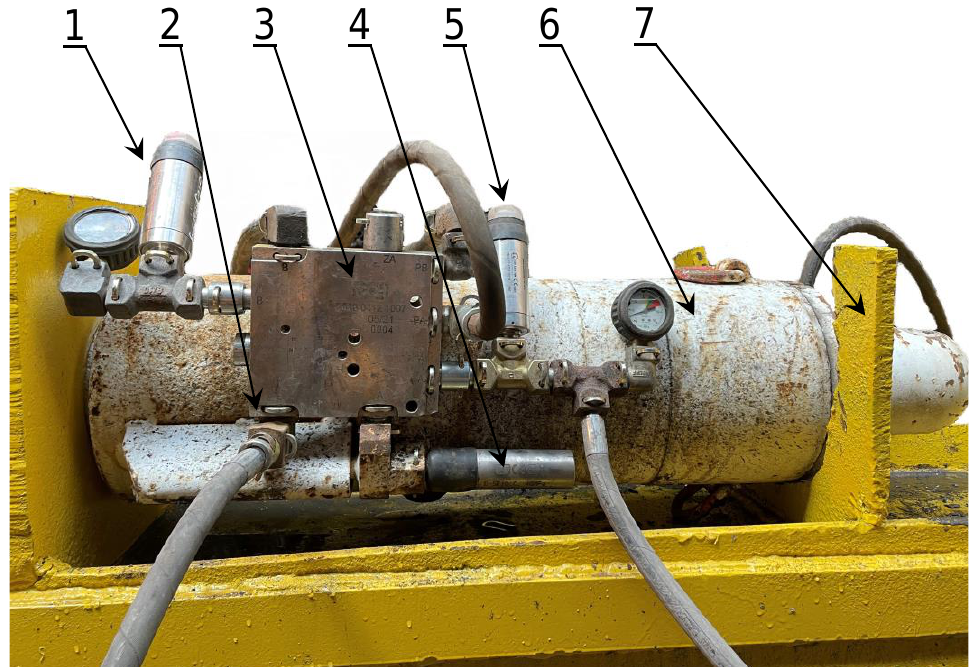
Figure 3. View of the test bench for verification of the double block charging function, where: 1 — pressure sensor for the supra-block space, 2 — pressure charging, 3 — double block with pressure charging, 4 — safety valve, 5 — pressure sensor for the sub-block space, 6 — hydraulic prop, 7 — frame of test site.